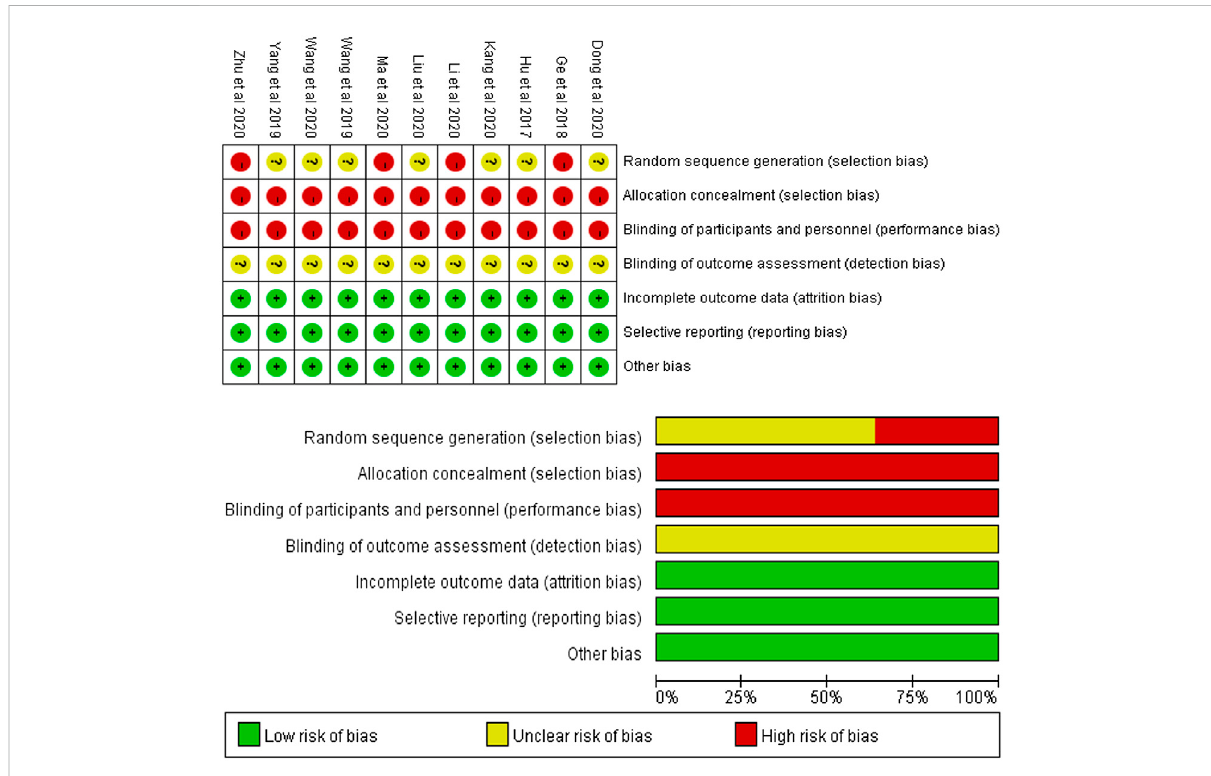
FIGURE 2 Assessment of methodological quality by the Cochrane risk-of-bias